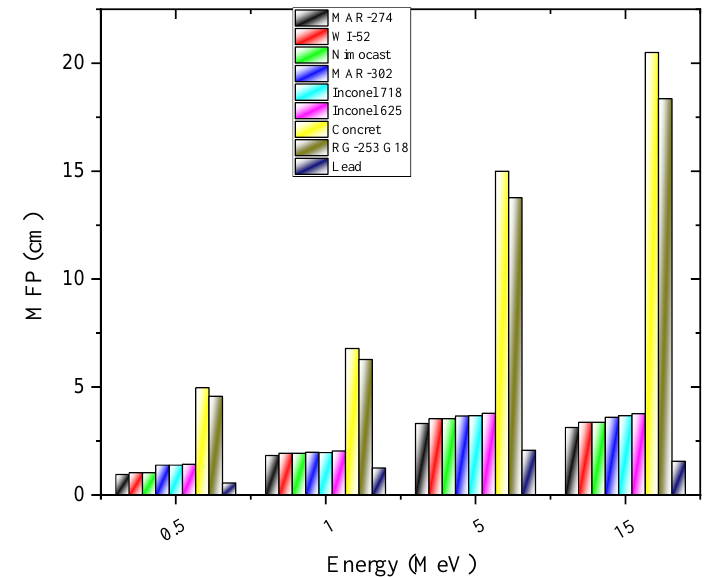
Figure 4. The mean free path (MFP) of the studied alloys versus incident gamma-ray energy. The effective atomic number (Z eff ) is used to describe a multi-element material in terms of its elements. The calculation of Z eff is based on the calculated MAC, electronic cross section, and atomic cross section. The variation of the Z eff versus the γ-ray energies is presented in Figure 5a for the investigated alloys. The Z eff trend can be explained through photon interaction phenomena. Values reach their maximum in the PE interaction region because of the dependence of the photoelectric cross-section with Z 4–5 [34]. In the PE interaction region, two sudden increases appeared at around 0.02 and 0.07 MeV. The first increase appeared at around 0.02 MeV for the Inconel-625 and Inconel- 718 alloys. This increase was due to the K-absorption edges (X-ray) of Nb and Mo, which appeared at 0.019 and 0.02 MeV, respectively. The second increase was detected at around 0.07 MeV for MAR- 247, MAR-302, and WI-52 alloys. This second increase was due to the W K-edges, which appeared at 0.069 MeV. Then, the Z eff values sharply decreased with the increase in γ-ray energy because of the PE cross-section, which was proportional to E −3.5 . In the region where CS was dominant, Z eff demonstrated a moderate reduction with an increase of γ-ray energy, since the CS cross-section varied with Z. Above several MeV, the Z eff reversed its downward trend and began to increase with an increase in photon energy due to the PP cross-section, which varied with Z 2 .